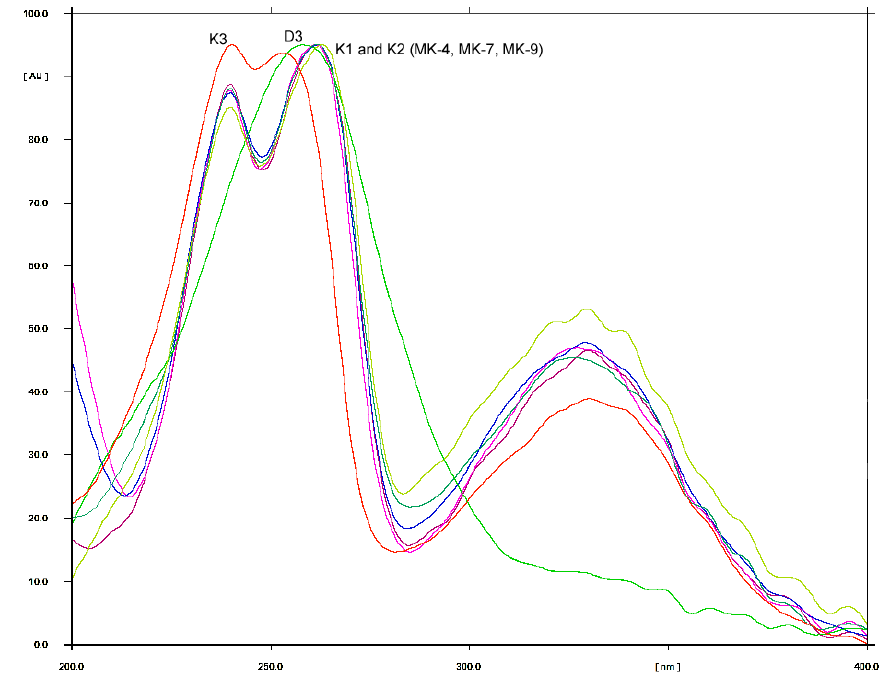
Figure 3. Overlay UV absorption spectra of standards registered directly from the densitogram.